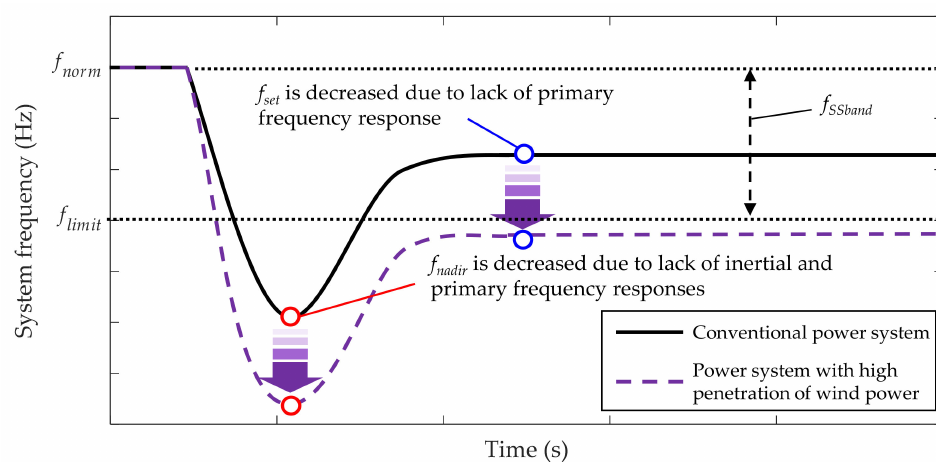
Figure 3. The effect of wind power penetration on frequency